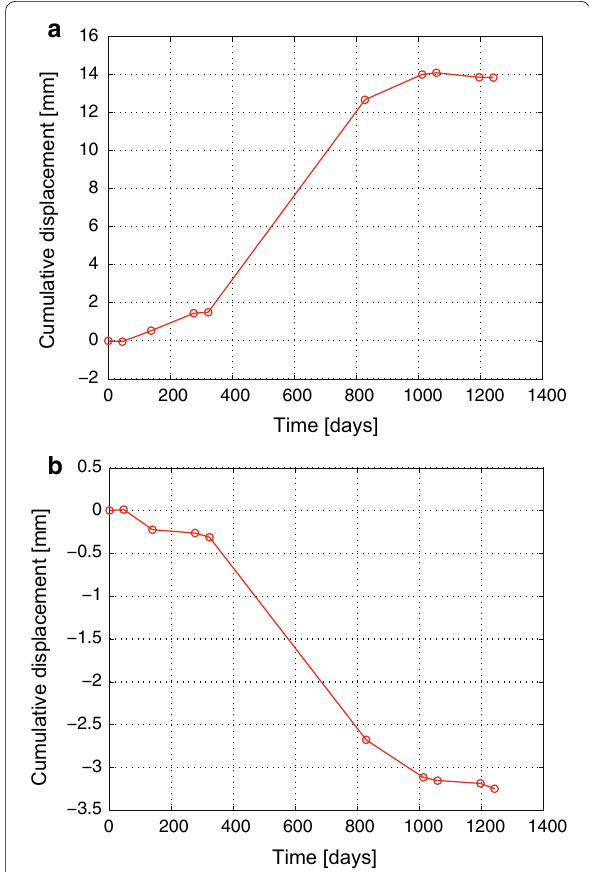
Fig. 10 Time-series plot of cumulative displacements. The cumula- tive displacements at points X and Y in Fig. 7 are plotted in a and b , respectively. The red circle corresponds to the date of SAR